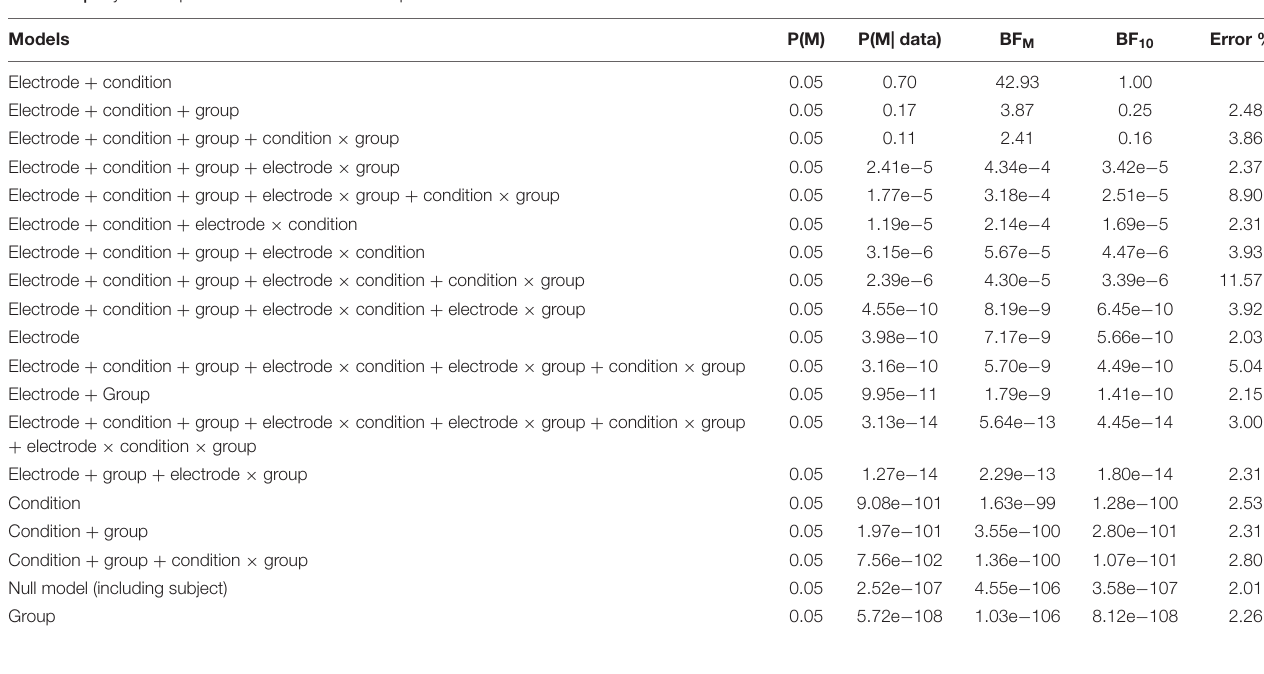
TABLE 5 | Bayesian repeated measures model comparison for the